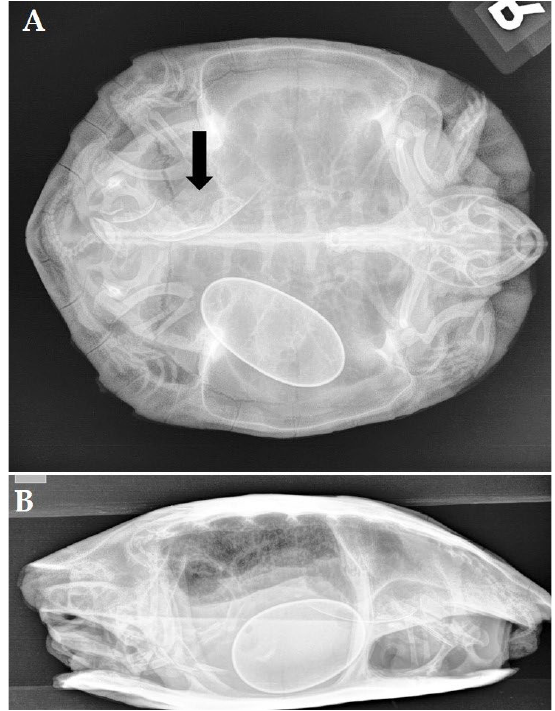
Figure 4. Ventrodorsal ( A ) and laterolateral ( B ) radiograph of a black marsh turtle ( Siebenrockiella crassicollis ) showing mild generalized decreased mineralization of the skeleton and a large, excessively calcified egg in the left caudal coelomic cavity as well as the remnants of an eggshell (arrow) in the right coelomic cavity.